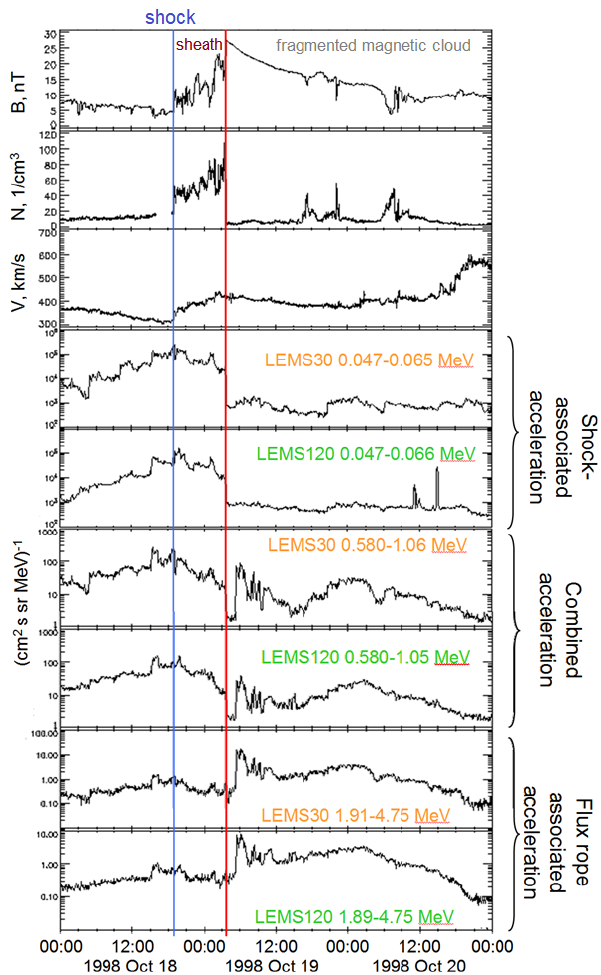
Figure 4. Energetic ion flux enhancements caused by different mechanisms as observed in the same stream. From top to bottom: the IMF strength, plasma parameters (density and speed) from ACE (at L1), and ion flux from ACE LEMS30 and LEMS120 (see cor- responding energy channels indicated). The first ion flux enhance- ment is clearly associated with the IS (blue line) as seen in lower energy channels. The role of diffusive shock acceleration decreases with increasing energy, but, beginning with ∼ 0.6MeV, local par- ticle acceleration is seen in the fragmented magnetic cloud region filled with flux ropes/plasmoids/magnetic islands and strong current sheets. Adapted from Khabarova and Zank